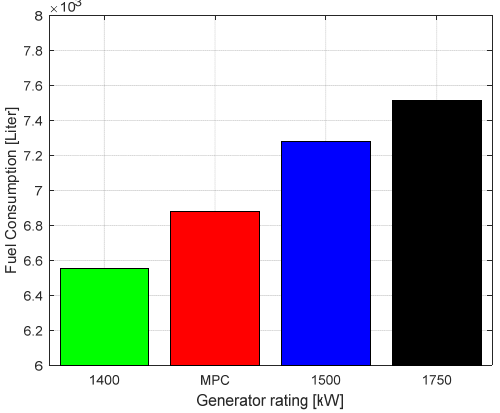
Figure 10. Diesel generator fuel consumption comparison for 24 h operation.